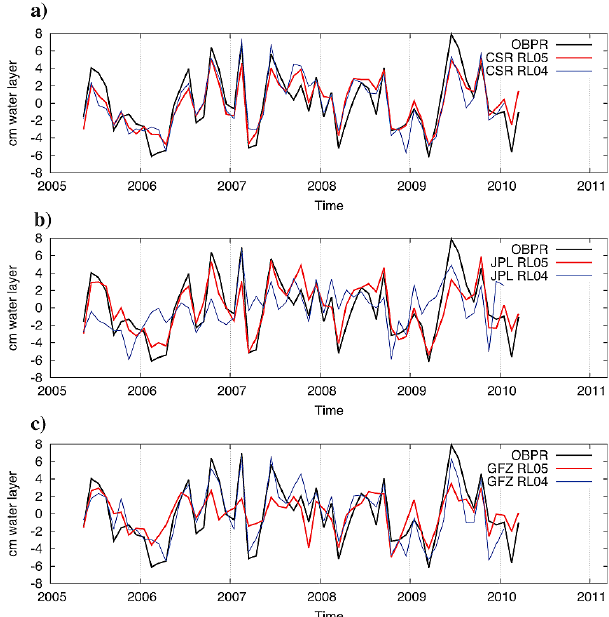
Fig. 6. Time series of OBP at the North Pole measured by a BPR (black line) and (a) CSR RL04 & CSR RL05, (b) JPL RL04 & JPL RL05, and (c) GFZ RL04 & GFZ